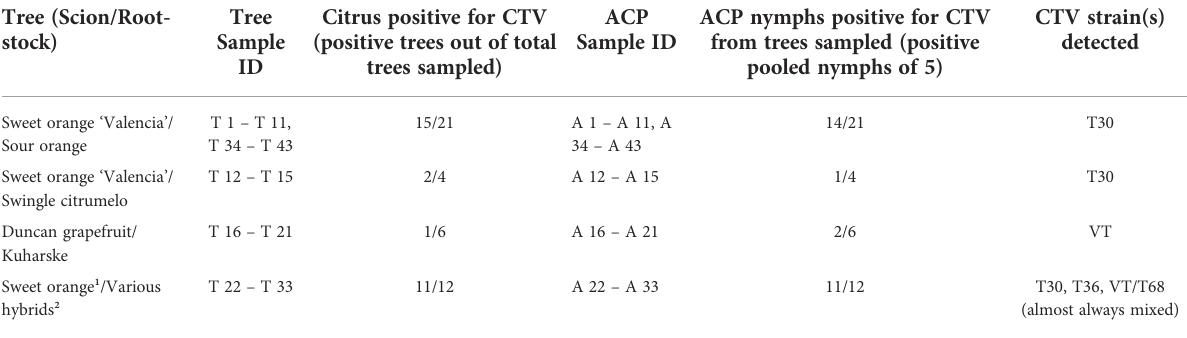
TABLE 6 Summary of citrus tristeza virus (CTV) strain prevalence in comparative study of citrus trees and Asian citrus psyllid ( Diaphorina citri ; ACP) nymphs. Tree